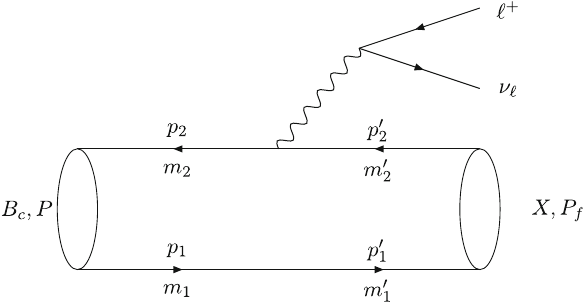
Fig. 1 Feynman diagram of the semileptonic decay B c → X (cid:10) + ν (cid:10) , where X denotes Z ( 3930 ) or X ( 4160